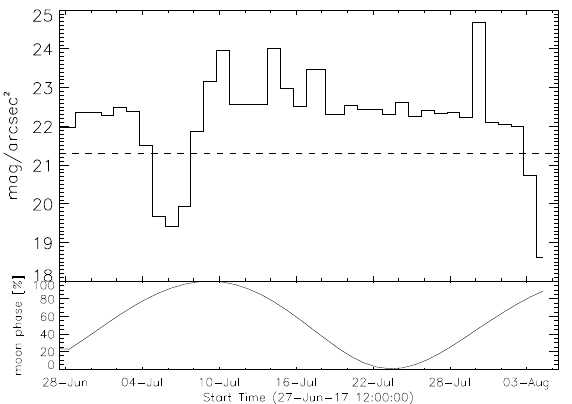
Figure 6. The plot for Picacho (2,730 meters altitude) meteorological measurements from January to May 2017. Top panel: Temperature. Bottom panel: Humidity, whose modulations are due mainly by a couple of seasonal events, the cold fronts which occur during the first 3–4 months of the year and the Mexican monsoon from the end of spring to the end of summer.